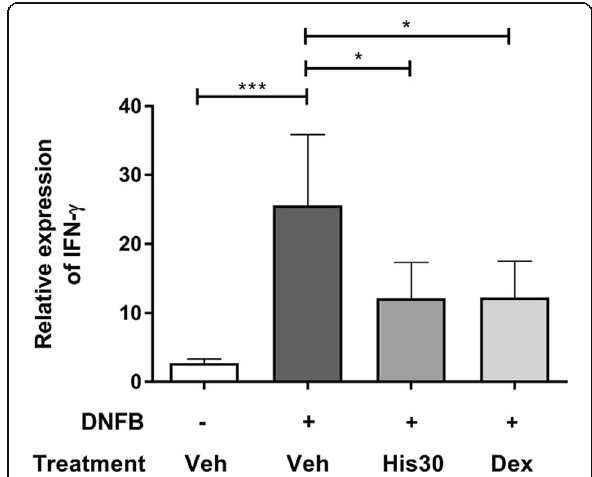
Fig. 3 Relative mRNA expression of IFN- γ in mouse ears. Relative mRNA expression of IFN- γ to β -actin in ear tissues from mice with or without DNFB sensitization (+,-) and DNFB-sensitized mice with 30 μ g/ear hispidulin (His30) or 30 μ g/ear dexamethasone (Dex) or vehicle alone (sensitized control) were measured at 24-h post-